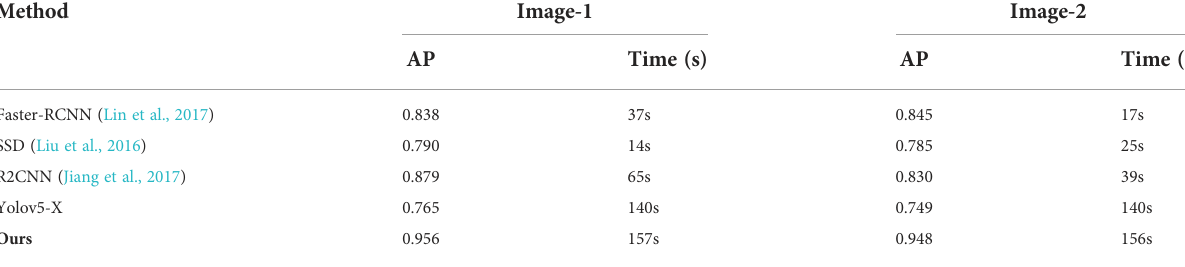
TABLE 6 Detection outcomes of various CNN-based approaches on two SAR large scene ship